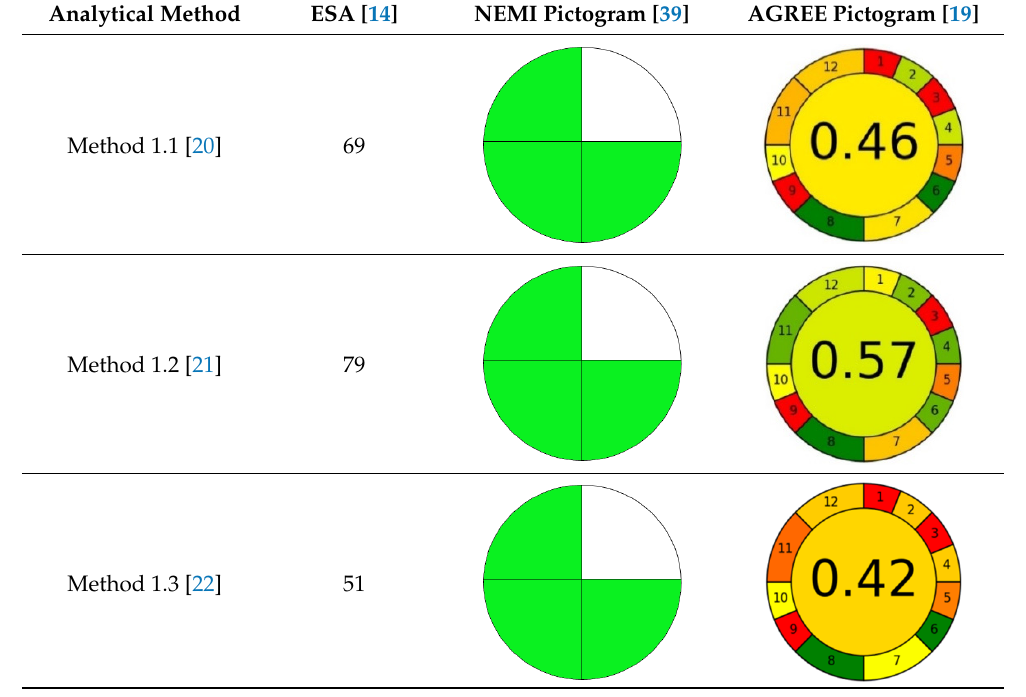
Table 1. Greenness assessment results of methamphetamine and captagon analytical procedures.